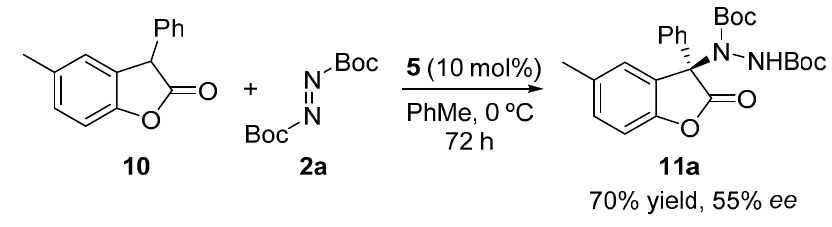
Figure 3. Proposed reaction